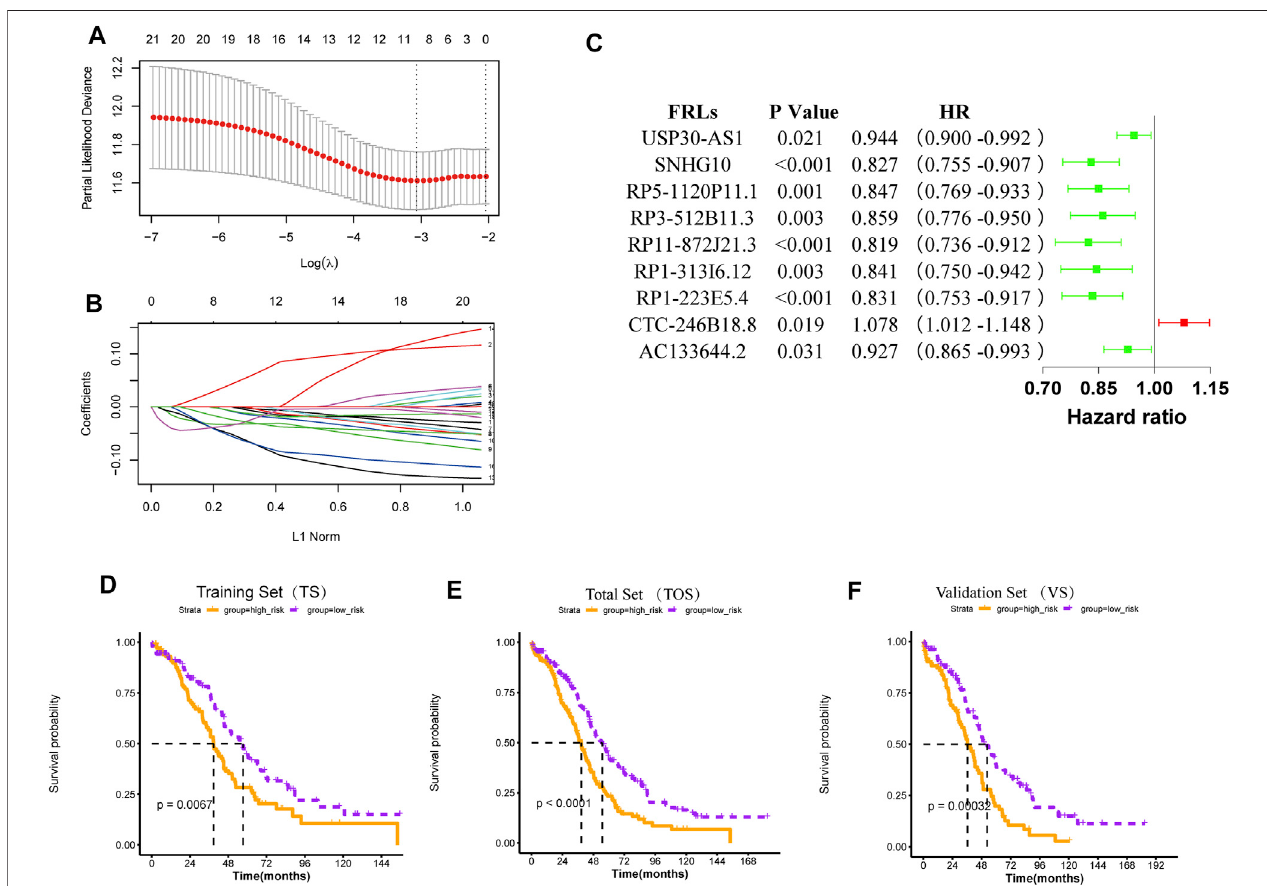
FIGURE3| Constructionandvalidationoftheriskmodel (A) λ selectiondiagram.Thetwodottedlinesindicatedtwoparticularvaluesof λ .Theleftsidewas λ min and the right side was λ 1se . The λ min was selected to build the model for accuracy in our study (B) LASSO Cox analysis (C) Forest plot of the prognostic ability of the nine optimal FRLs (D-F) The K-M survival curves of training set (D) , total set (E) , and validation set (F) .